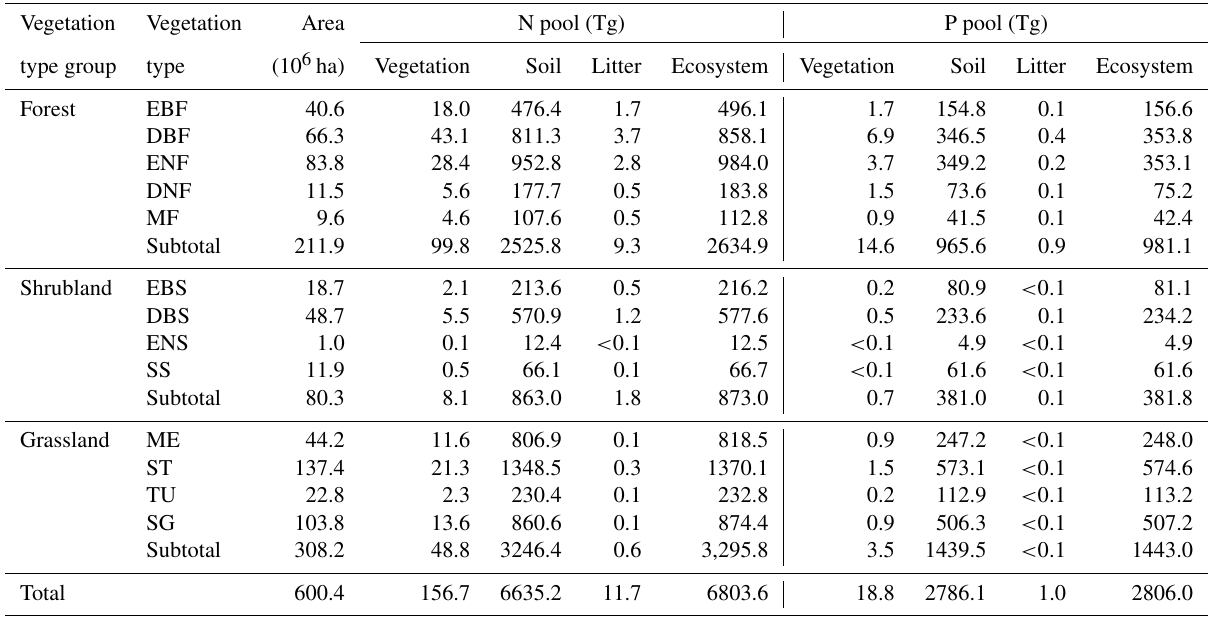
Figure 3. N and P density allocations among leaf, stem, and root (a, b) and between vegetation and soil (c, d) in 13 vegetation types. See Table 1 for abbreviations. The error bar represents standard error. Notice that the y axes above and below zero are disproportionate.